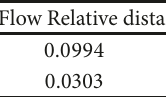
Table 9: Costs and Flows Relative Difference, Both Approaches (two congestion